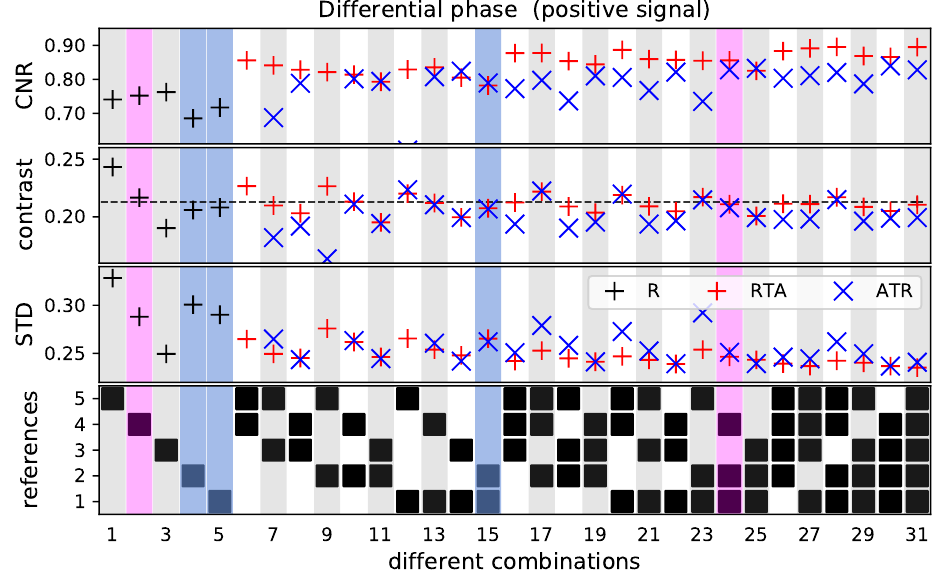
Figure 4. CNR, contrast and STD for the ROI of the positive DPC signal, marked in Figure 2a. The STD and contrast values are given in the radian. The plot in the last row indicates which reference images were used for deriving the values in the respective column. The red and blue markers show the results for reconstruct-then-average (RTA) and average-then-reconstruct (ATR), respectively. The black markers indicate the values for which only one reference image is used. The black dashed line indicates the mean contrast of the first five combinations. For the combinations 6, 9 and 12, the ATR method results in images with high standard deviation and low CNR, which are not within the range of the axis. Furthermore, the contrast is for the combinations 6 and 9 not within the range of the axis. The values in the colored columns were used for a detailed